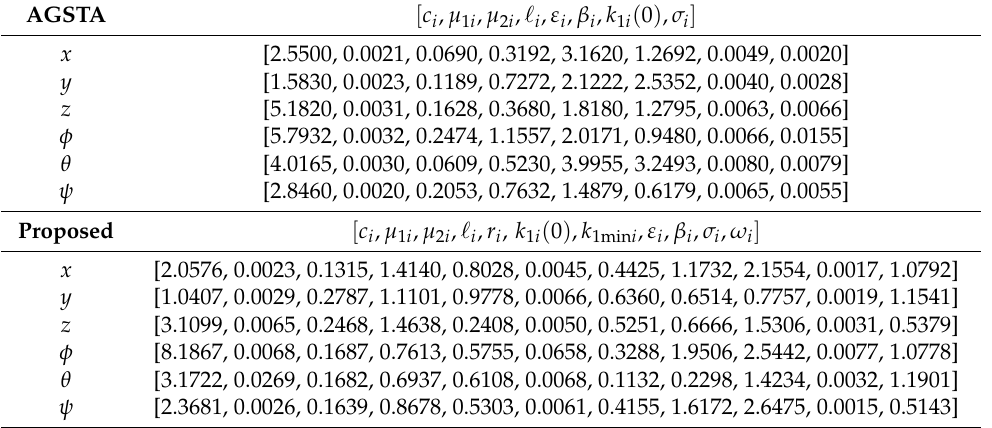
Table 2. Controller parameters for the